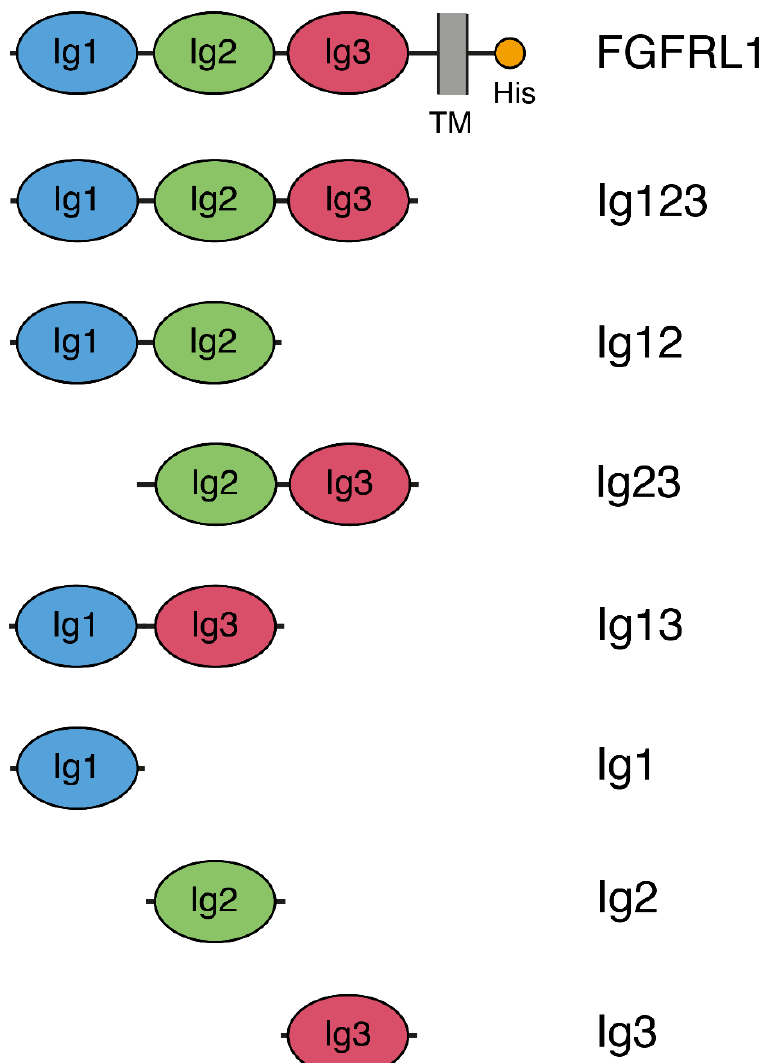
Figure 1. Schematic drawing of protein constructs expressed in human cells. The full-length fibroblast growth factor receptor-like protein 1 (FGFRL1) is indicated at the top with three Ig domains, a transmembrane helix (TM) and a short, histidine-rich intracellular domain (His). The entire extracellular domain (Ig123), all combinations containing two Ig domains (Ig12, Ig23, Ig13) as well as all individual Ig domains (Ig1, Ig2, Ig3) were expressed in HEK293 cells.